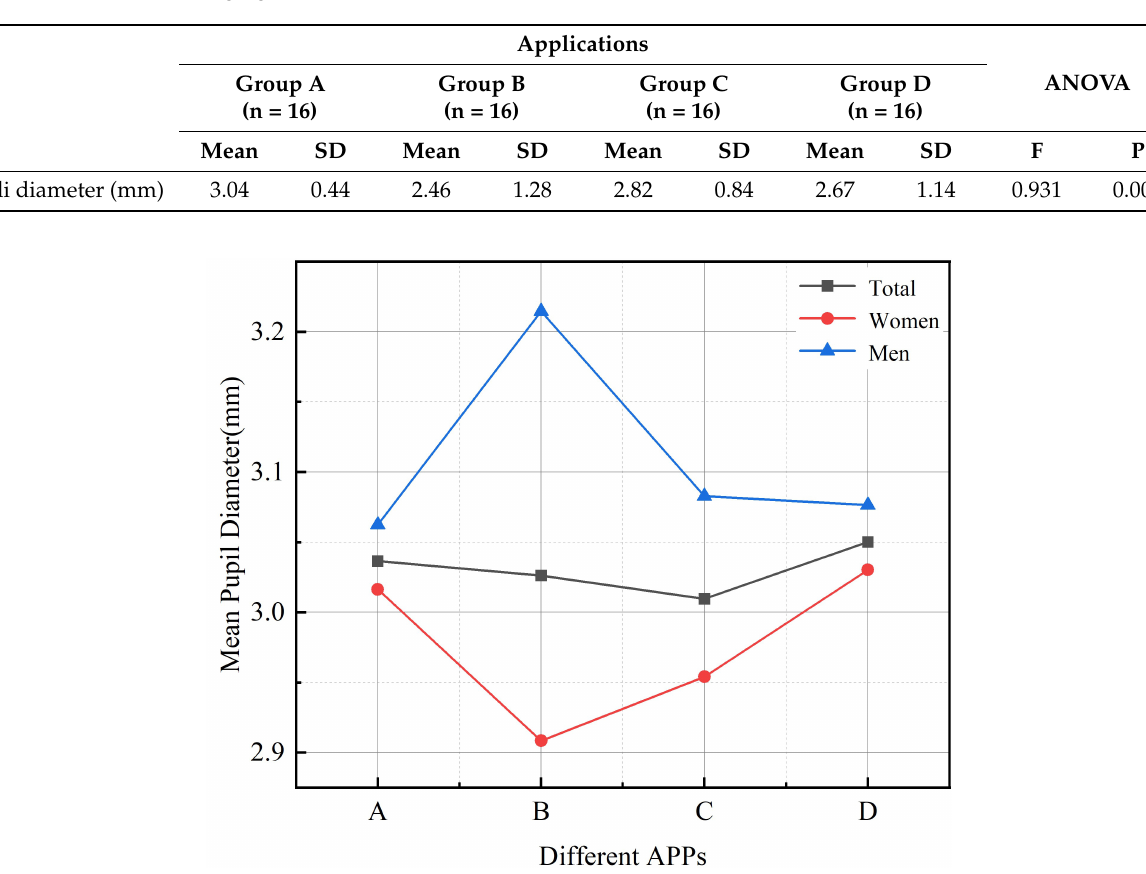
Figure 5. Line graph of mean pupil diameter of participants with different Apps: A refers to C-life Senior Care APP; B refers to Senior Living APP; C refers to Senior Care Manager APP; D refers to Smart Aging